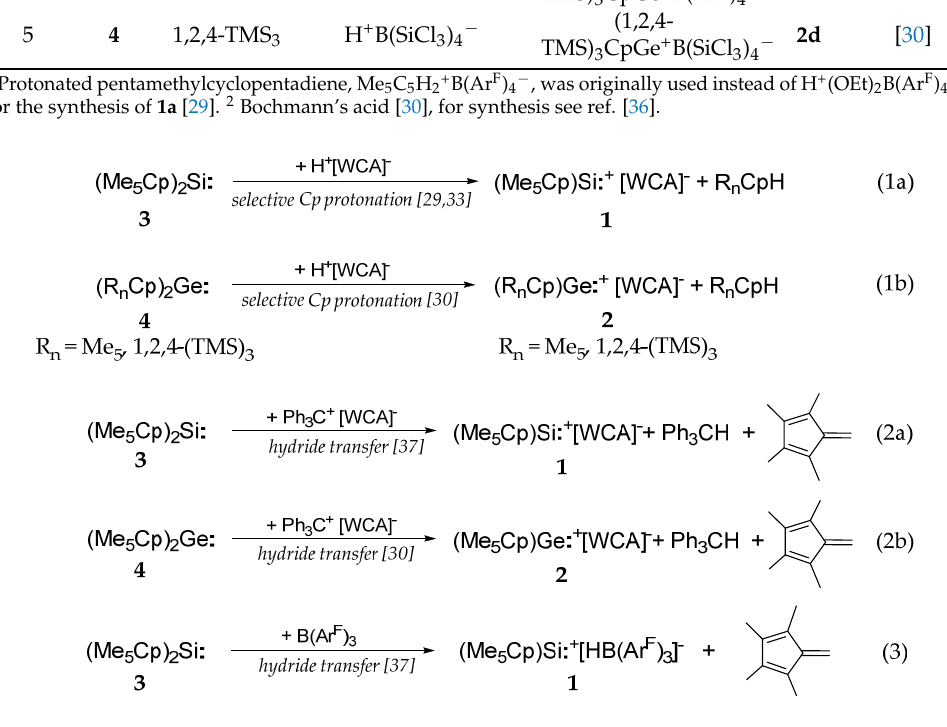
Table 2. Synthesis of catalysts 1 and 2 , by hydride transfer reaction from the corresponding tetre- locenes 3 and 4 to electrophiles